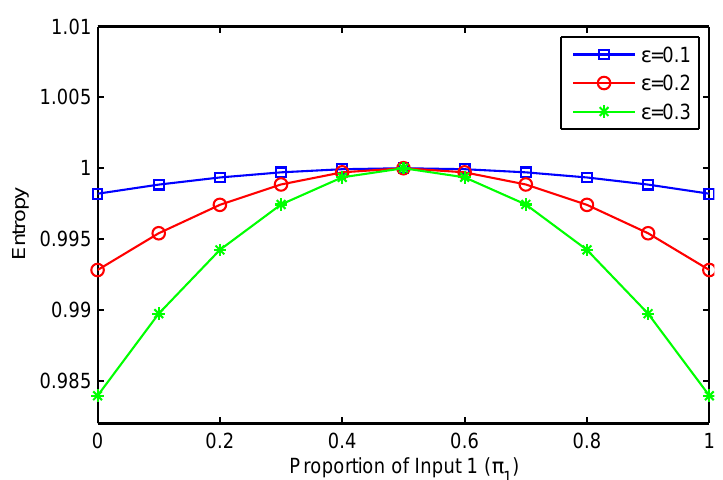
Figure 11. Entropy of output of bivariate randomized response mechanism under different π 1 .